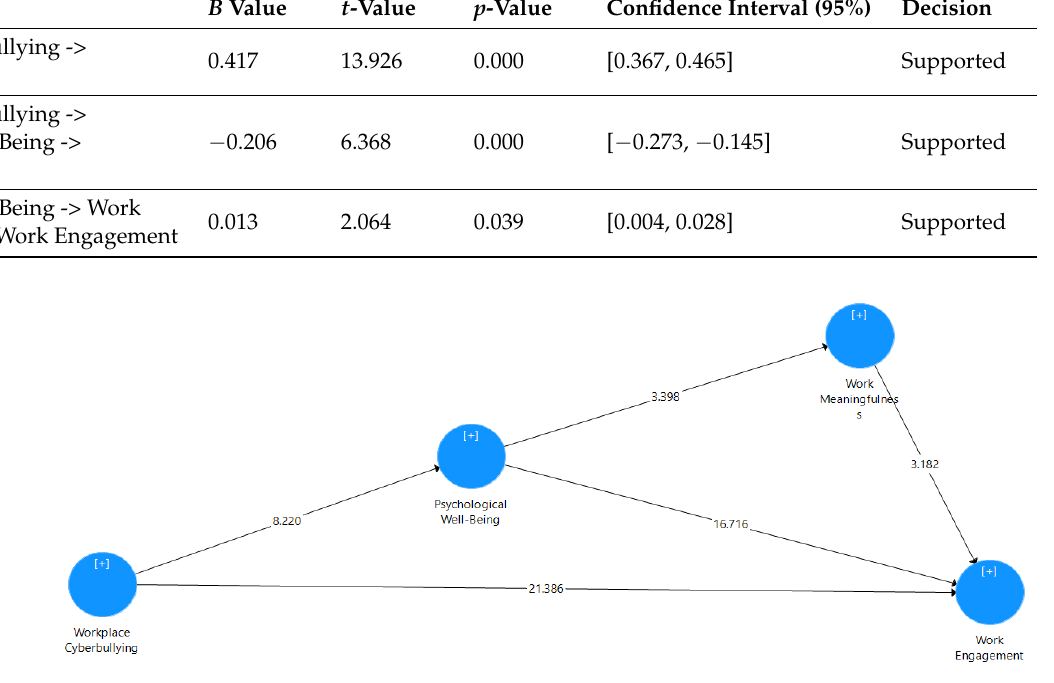
Figure 2. Structural